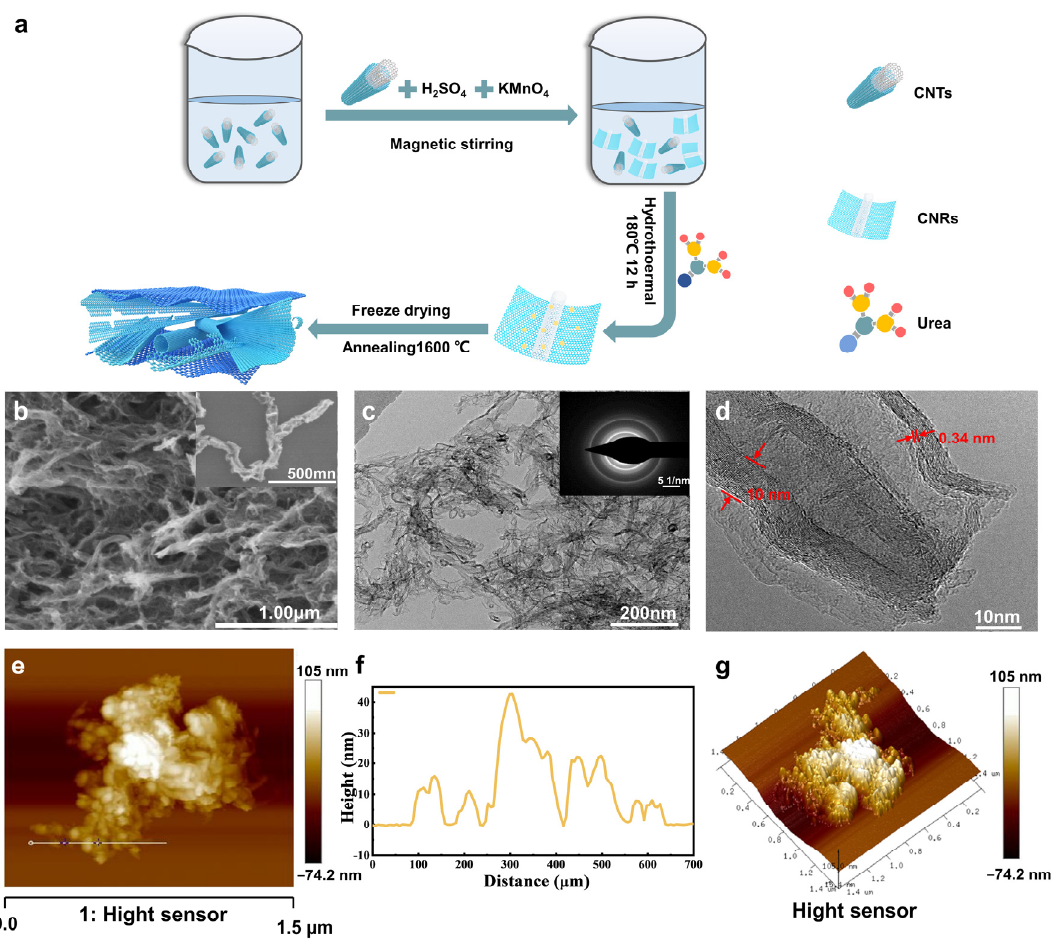
Figure 1. ( a ) Schematic diagram for the preparation of the GNRs composite. ( b ) SEM image of GNRs. The inset in ( b ) shows the SEM image of GNRs at a different scale. ( c ) TEM image of the GNRs composite. The inset in ( c ) shows the SAED pattern of GNRs. ( d ) HRTEM image of GNRs. ( e ) AFM image of GNRs. ( f ) Height pro fi le of the trace line in ( e ). ( g ) 3D AFM pa tt ern of the piece of the GNRs composite.